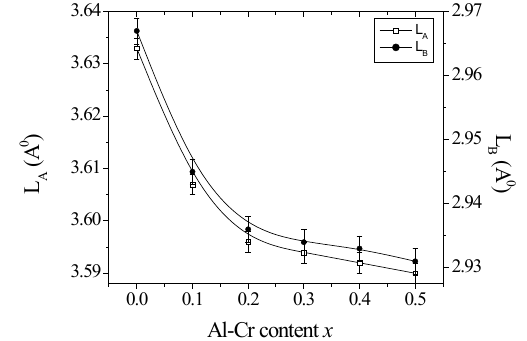
Figure 3. Variation of L